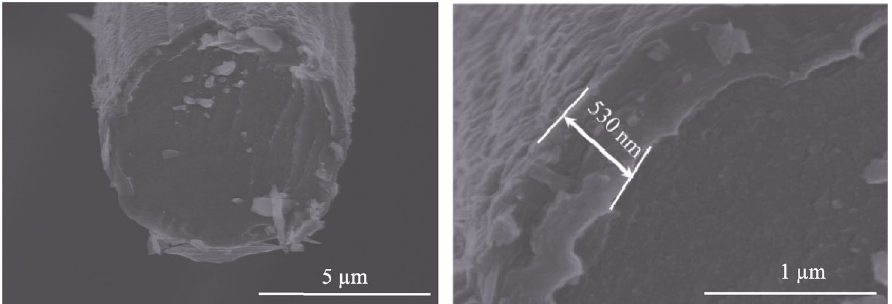
Fig. 7 SEM photos of PyC coating.